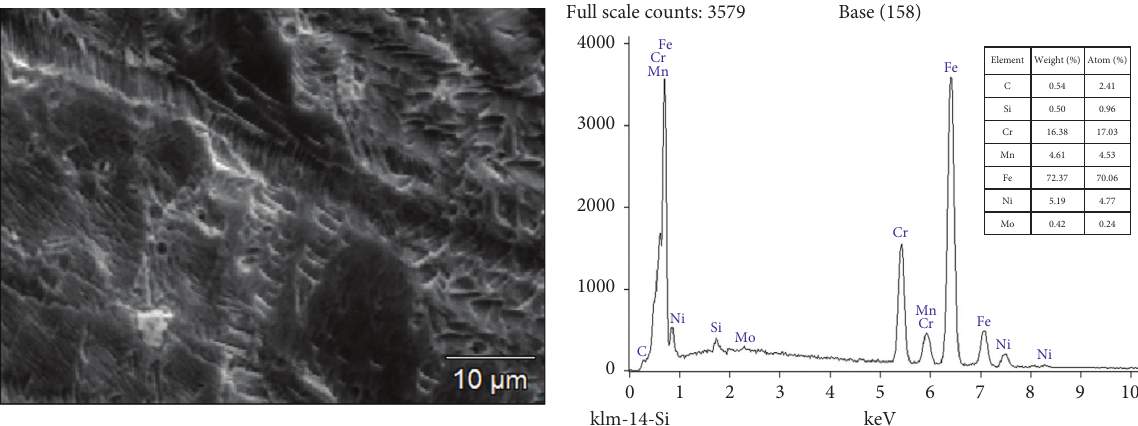
Figure 2: EDS and SEM investigation of the good material at dendritic multiperiod of 100 microns.